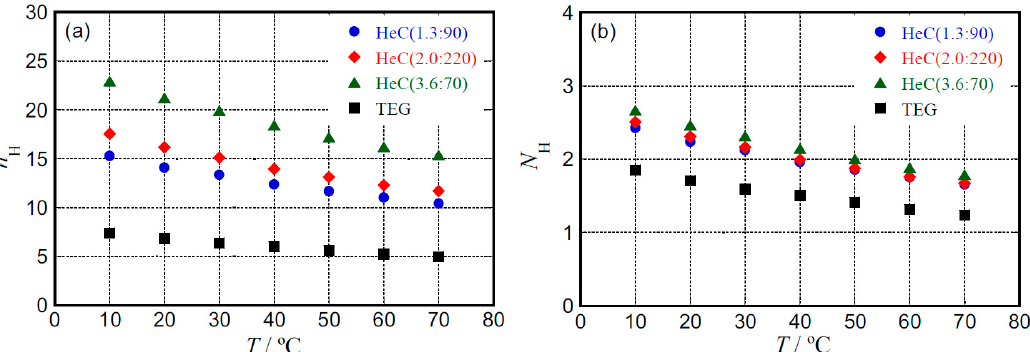
Figure 8. ( a ) Temperature, T , dependence of the hydration number, n H , per glucopyranose unit for HeC(1.3:90), HeC(2.0:220), and HeC(3.6:70) and that for triethylene glycol, TEG, per molecule. ( b ) T